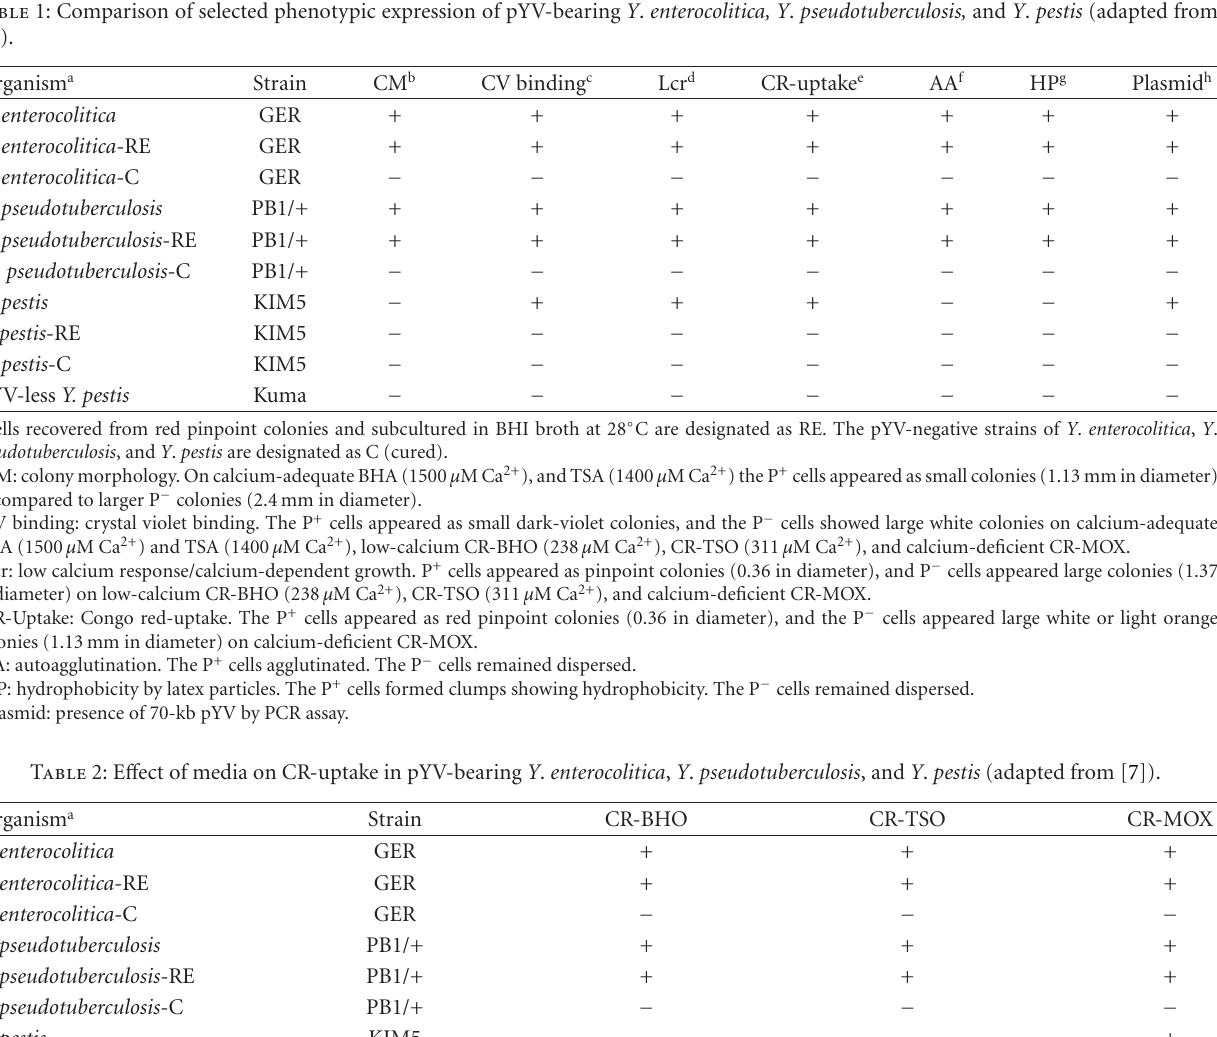
Table 1: Comparison of selected phenotypic expression of pYV-bearing Y . enterocolitica, Y . pseudotuberculosis, and Y . pestis (adapted from [7]). Organism a